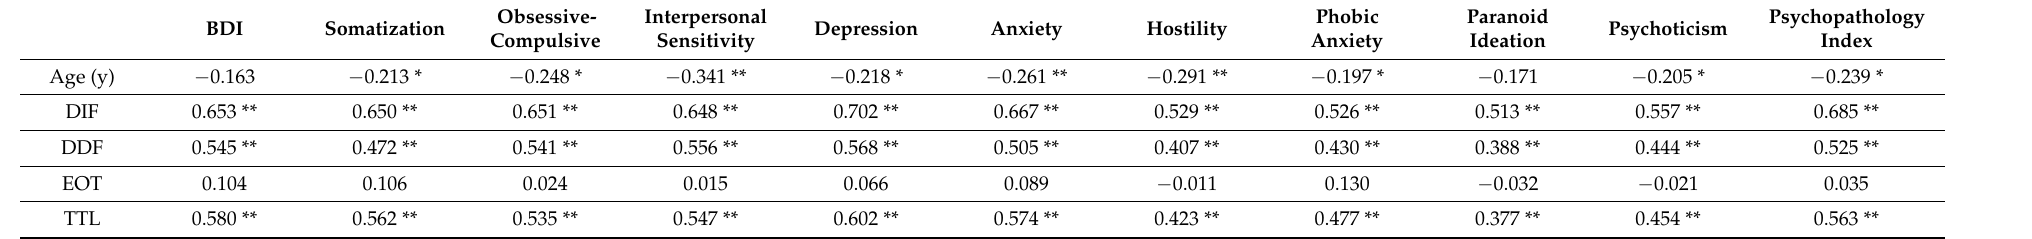
Table 2. Spearman correlation coefficients of BDI and SCL90 scales with the TAS-20